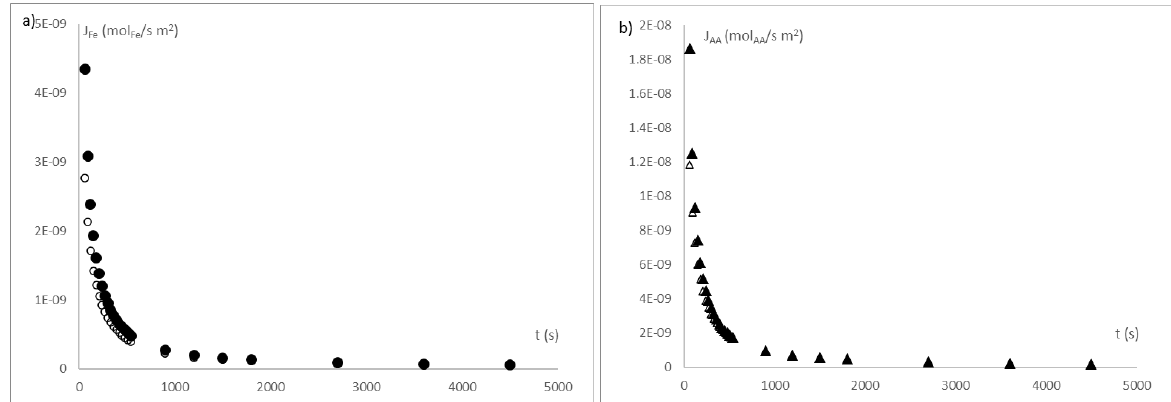
Figure 11. ( a ) Evolution of iron release flux (J Fe )and ( b ) Evolution of ascorbic acid release flux (J AA ). Where ( ● ) is iron ion released at pH of 3; ( ○ ) is iron ion released at pH of 4.7; ( ▲ ) is ascorbic acid released at pH of 3 and ( ∆ ) is ascorbic acid released at pH of 4.7. Notation is according to IuPAC.